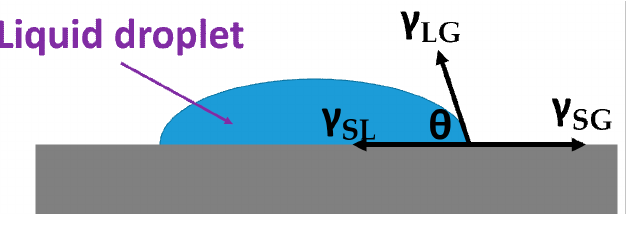
Figure 2. Interfacial tension distributed.